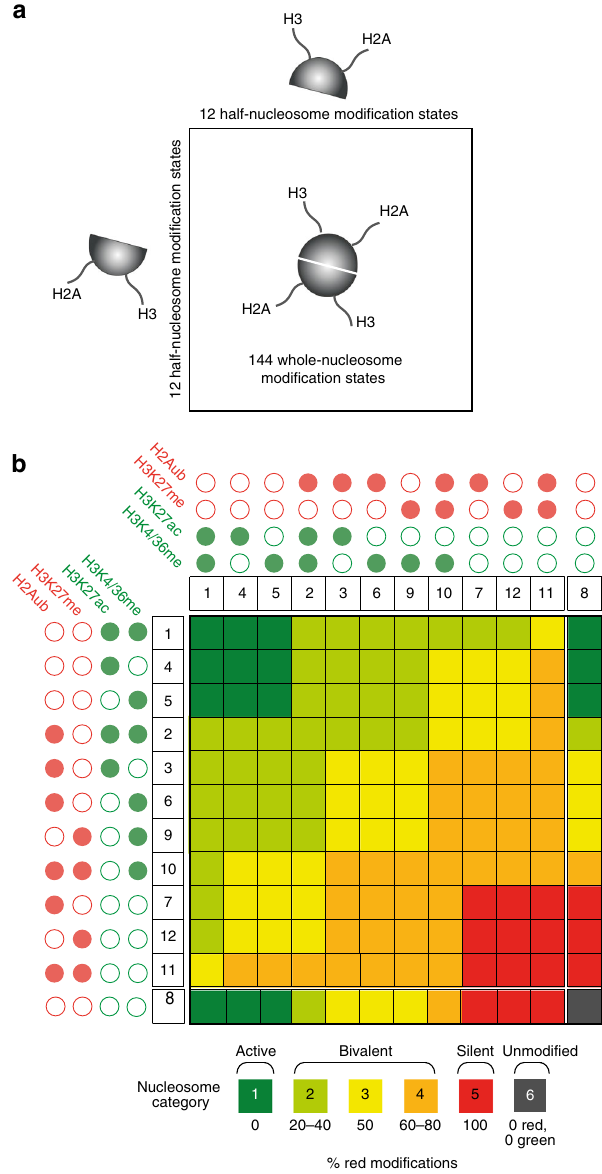
Fig. 2 12 half-nucleosomes combine to give 144 whole nucleosomes. a Each half-nucleosome contains a single H3 and a single H2A tail, each of which can be modi fi ed as shown in Fig. 1d, giving 12 possible different half- nucleosome modi fi cation states. Each of these half-nucleosomes can be combined with one of 12 opposite halves, giving 144 possible whole- nucleosome modi fi cation states. b Half-nucleosomes are shown above and beside the fi gure with numbers corresponding to Fig. 1b, d. Modi fi cations are indicated as closed circles. Red: modi fi cations associated with silencing; green: modi fi cations associated with activation. Whole nucleosomes are colour coded and assigned to categories according to the proportion of active and silent modi fi cations they contain. For simplicity, this is represented as % red modi fi cations in the colour chart below the plot. Note that when considering whole nucleosomes, we de fi ne bivalent nucleosomes as all those in categories 2, 3, and 4, which carry any combination of opposing marks, on the same or different half- nucleosomes that contain mostly active marks (category 2, light green, Fig. 2b), those that contain mostly silent marks (category 4, orange, Fig. 2b), and those that contain a balanced mix of both active and silent marks (category 3, yellow, Fig. 2b). Speci fi c individual NATURE COMMUNICATIONS| (2019) 10:2133